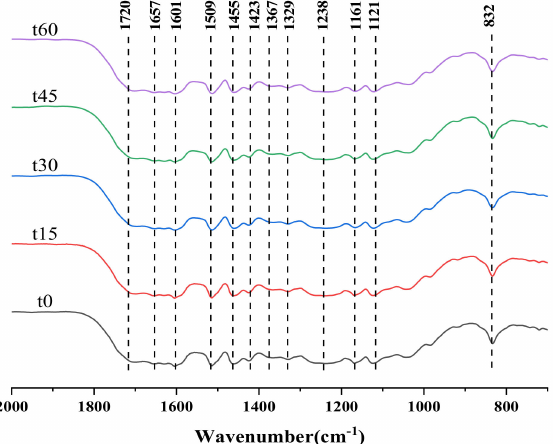
Figure 7. Infrared spectra of lignin obtained by the different sonication time treatments.